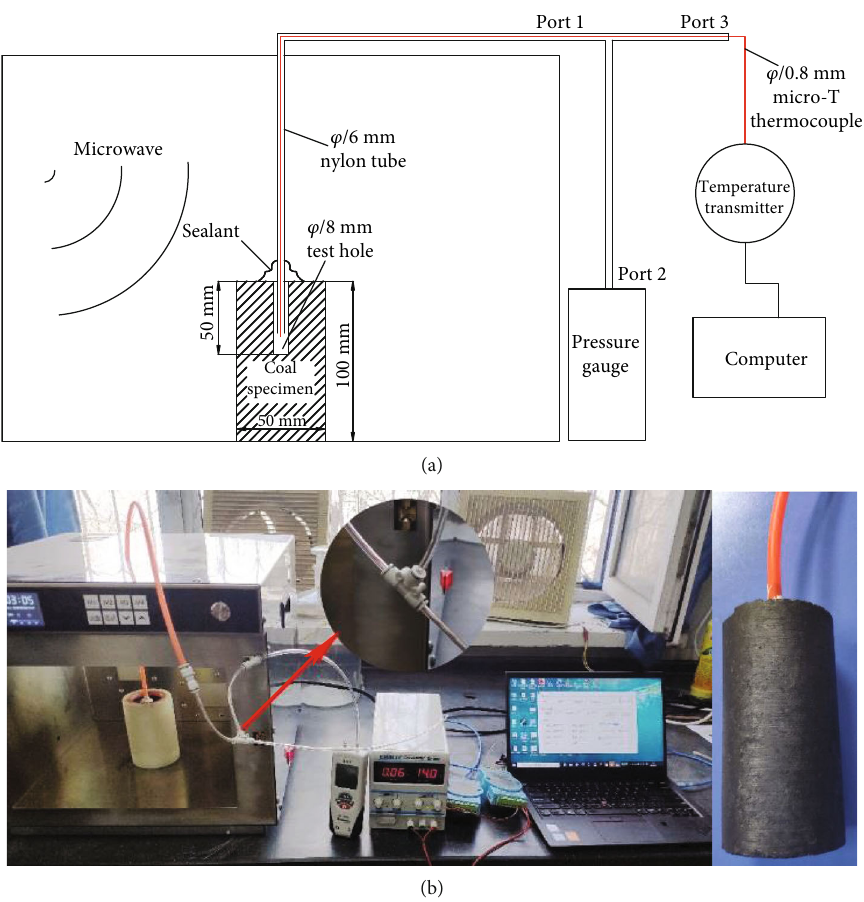
Figure 4: Gas pressure and temperature test system for microwave heating of water-bearing coal rock: (a) principle of the test device and (b) test device and coal rock sample.